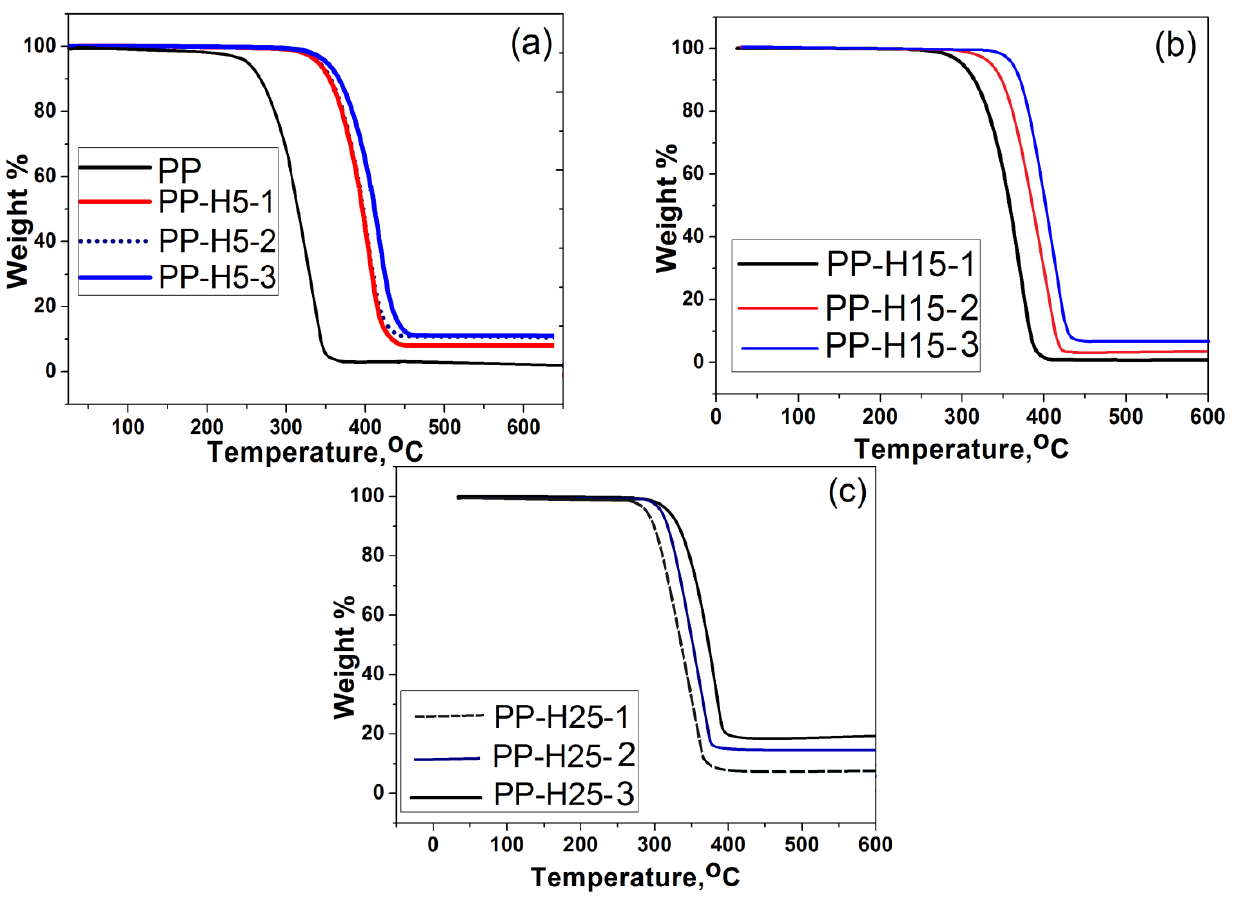
Figure 11. TGA analysis of ( a ) PP and PP-H5, ( b ) PP-H15 and ( c ) PP-H25 systems.